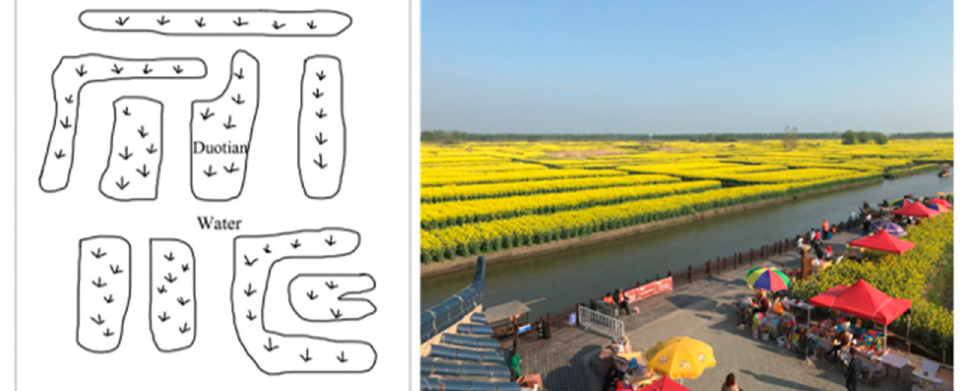
Figure 3. The sketch map and agri-landscape of Xinghua Duotian Agrosystem.